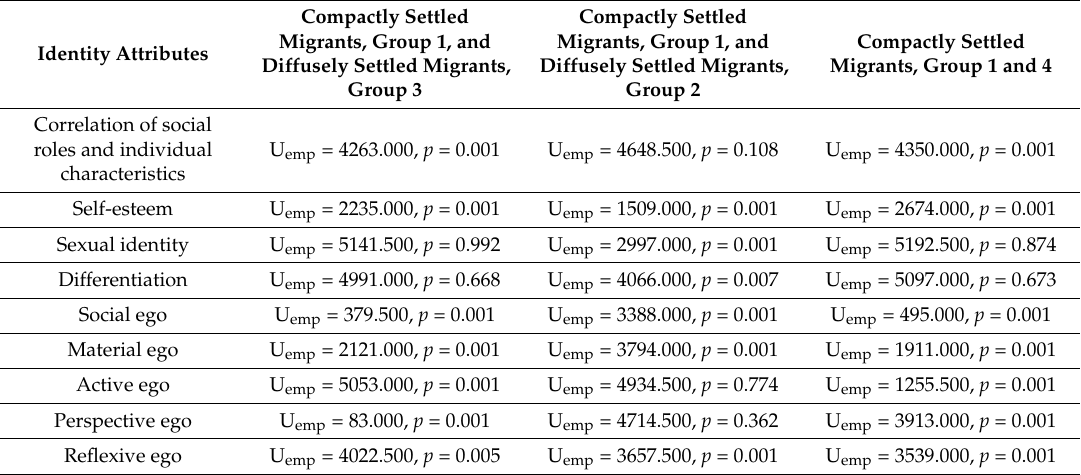
Table 2. Groups with significant differences compared to each other according to the Mann–Whitney test.